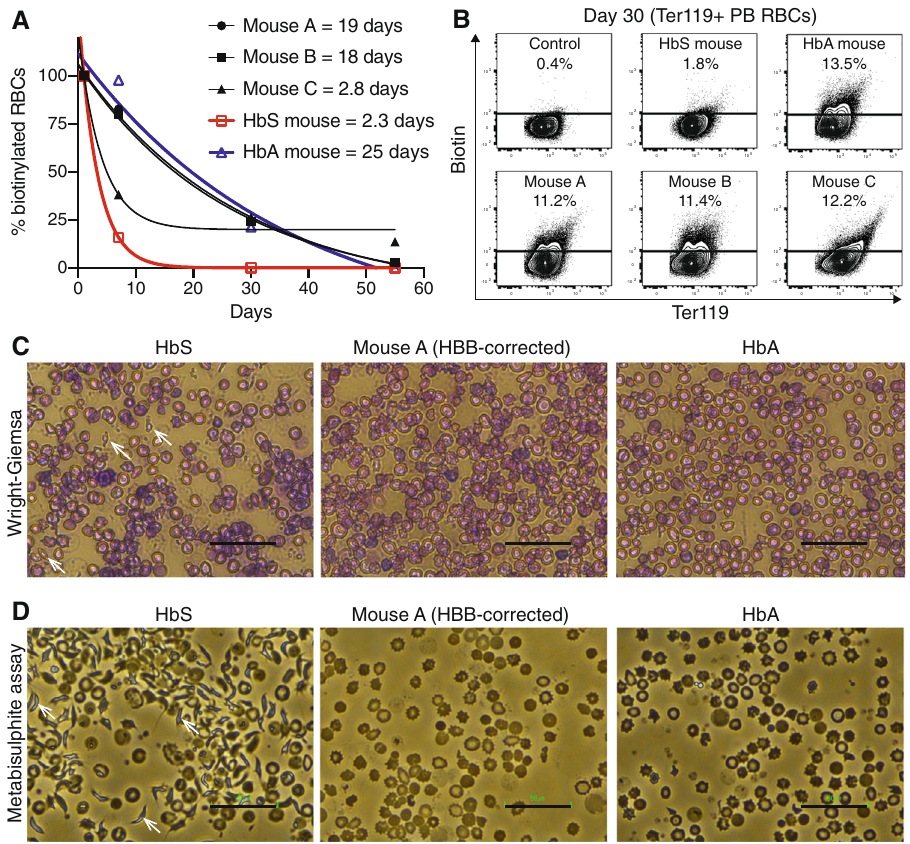
Fig. 3 Autologous HSCT using E6V-corrected SCD HSCs can correct erythropoiesis in vivo. A Half-life of EZH-biotin labeled Ter119 + PB RBCs, relative to labeling 24h post-injection of EZH-biotin (RBC labeling ef fi ciency at ~50%). Non-transplanted HbS and HbA mice included as controls. B Representative fl ow cytometric plots for Biotin vs Ter119 for Ter119 + PB RBCs at day 30 post-injection of EZH-biotin displayed in ( A ) and a no EZH-biotin injection control. C Representative Wright-Giemsa staining for PB from a non-transplanted HbS mouse, gene-corrected HSCT recipient (Mouse A), and a non-transplanted HbA mouse. Examples of abnormal RBC morphology indicated with white arrows. Representative for PB from Mouse A and Mouse B. Black scale bars indicate 50 µ m. D Representative images of metabisulphite sickling assays performed on PB from a non-transplanted HbS mouse, gene-corrected HSCT recipient (Mouse A), and a non-transplanted HbA mouse. Abnormal RBC morphology indicated with white arrows. Representative for PB from Mouse A and Mouse B. Black scale bars indicate 50 µ m. Source data are available in the Source data fi